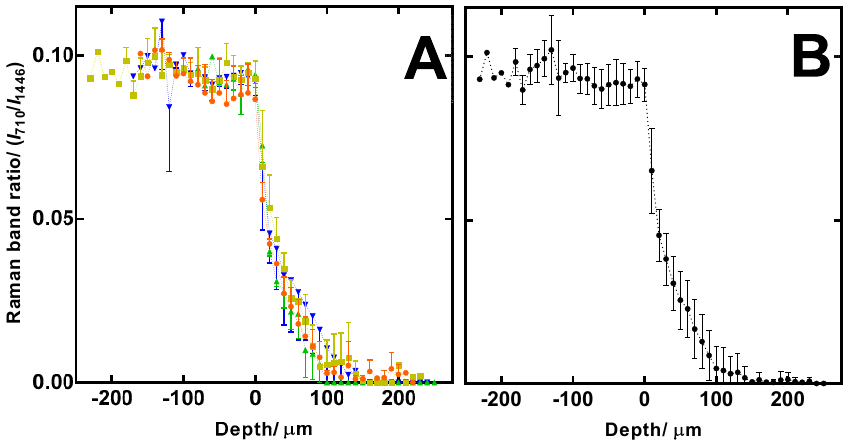
Figure 4. ( A ) Ciclopirox depth profiles in each of the 3D printed nails ( n = 4) from 3 scans (mean ± SD); ( B ) average ciclopirox depth profile for all 4 nail replicates (mean ± SD).